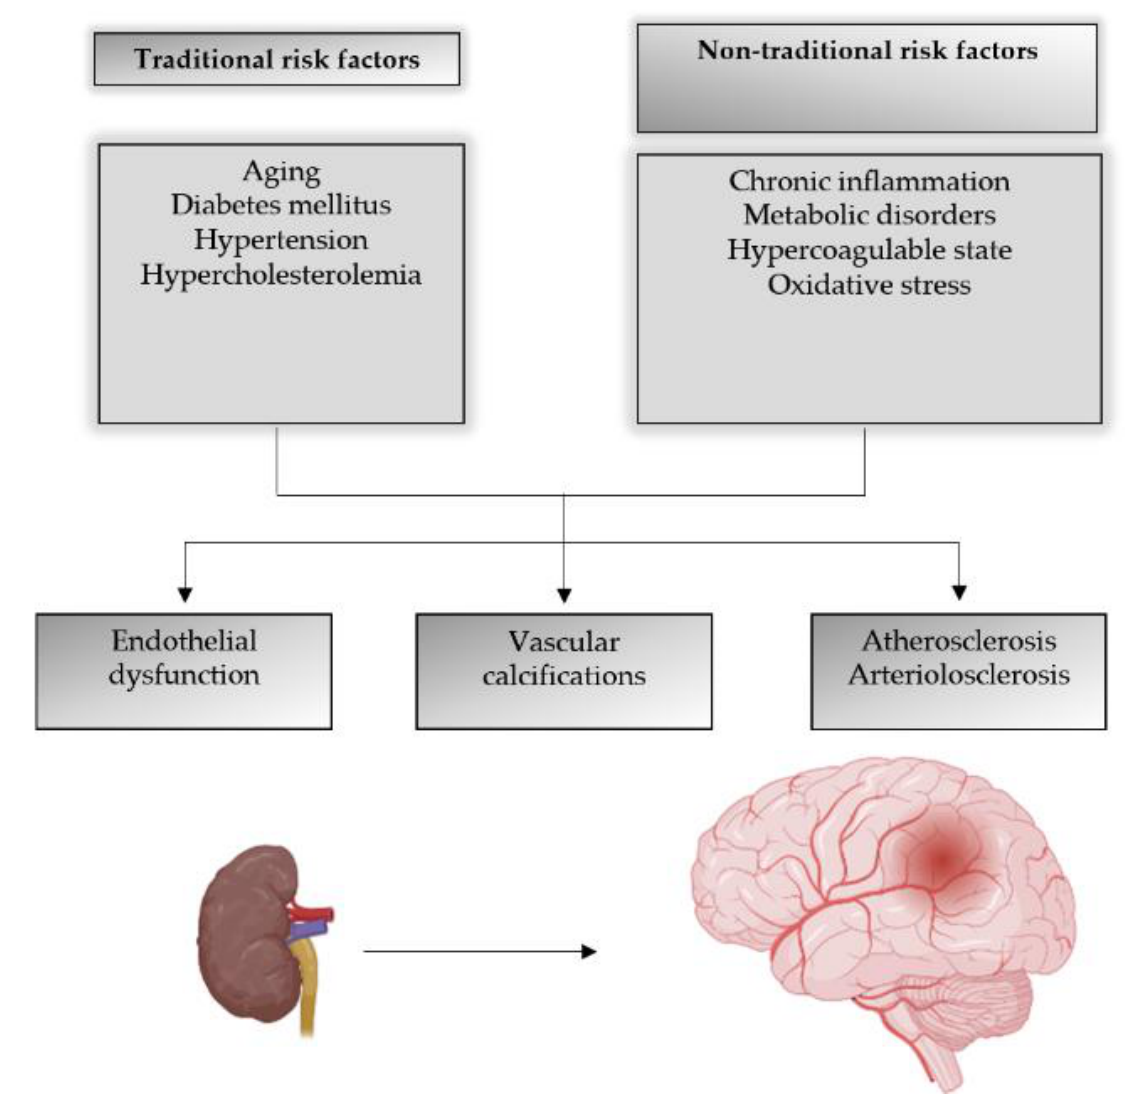
Figure 1. CKD as a risk factor for cerebrovascular disease.